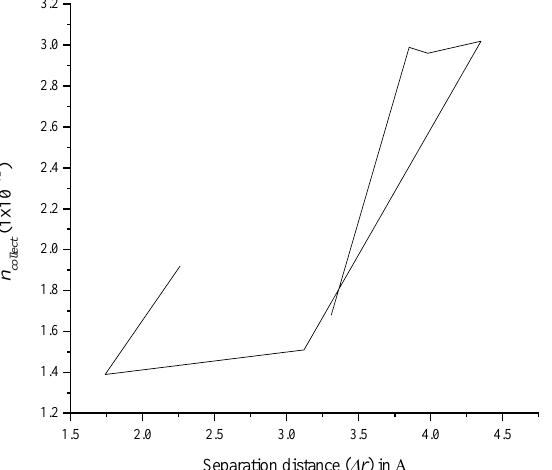
Figure 14. Graphical relationship between electron–hole separation distance and electron injection efficiency.